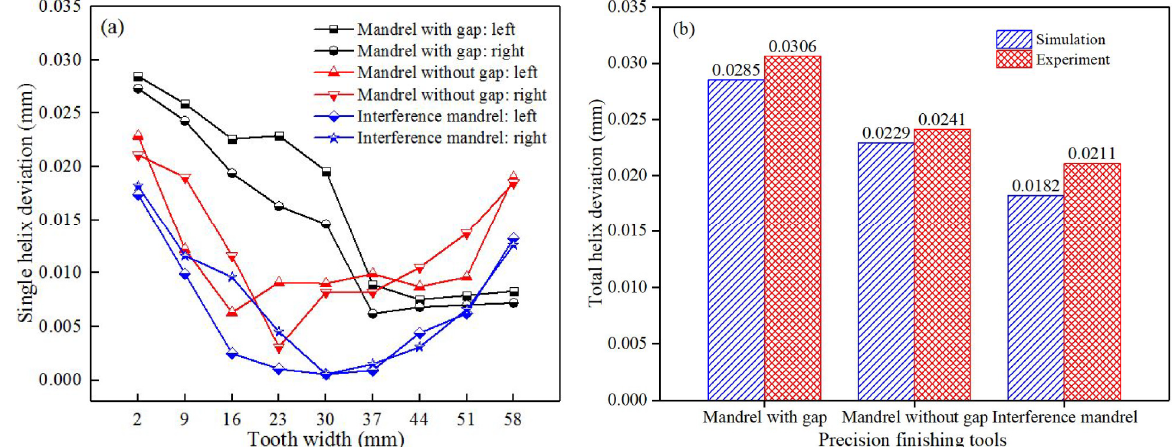
Fig. 10 Helix deviations of external gear at different finishing tools: (a) single; (b) total Figure 10. Helix deviations of external gear at different finishing tools: ( a ) Single and ( b )